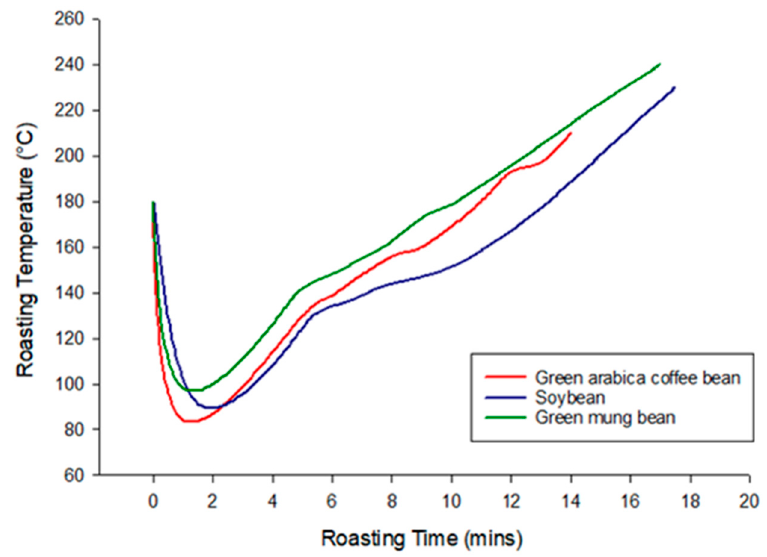
Figure 1. Roasting curves of green Arabica coffee beans, soybeans and green mung beans.